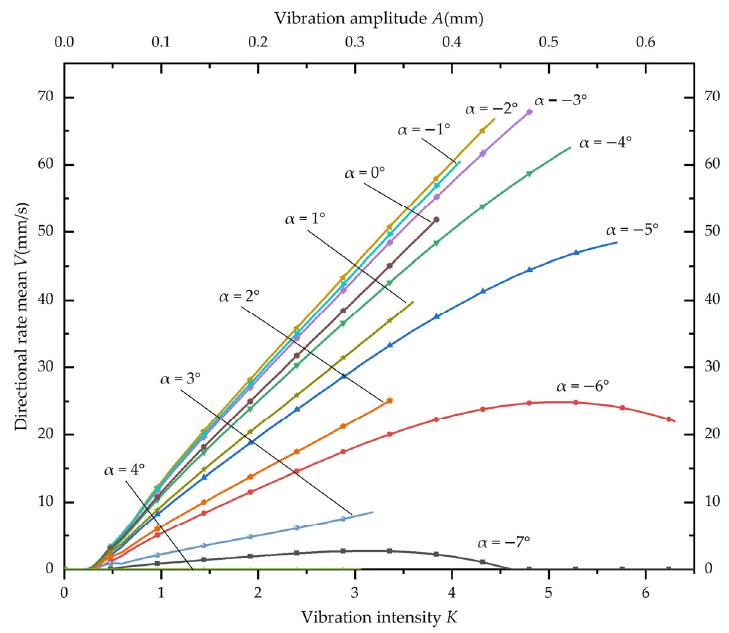
Figure 7. The trough is 316 L stainless